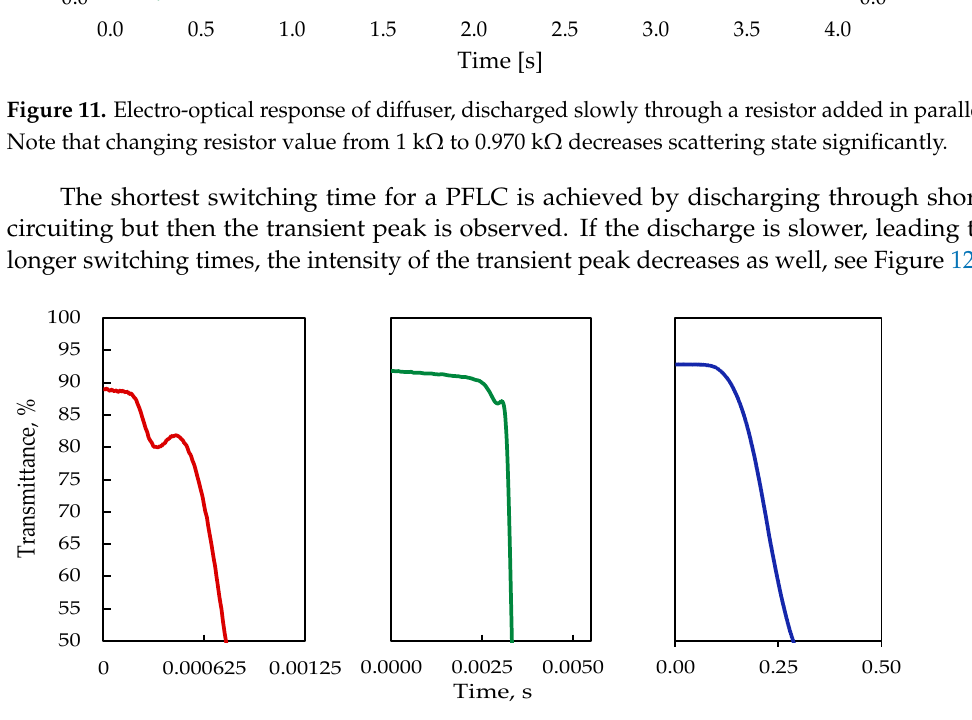
Figure 12. Transient peak intensity change going from fast ( left ) to slow discharge ( right ). Note that fall switching time increases.